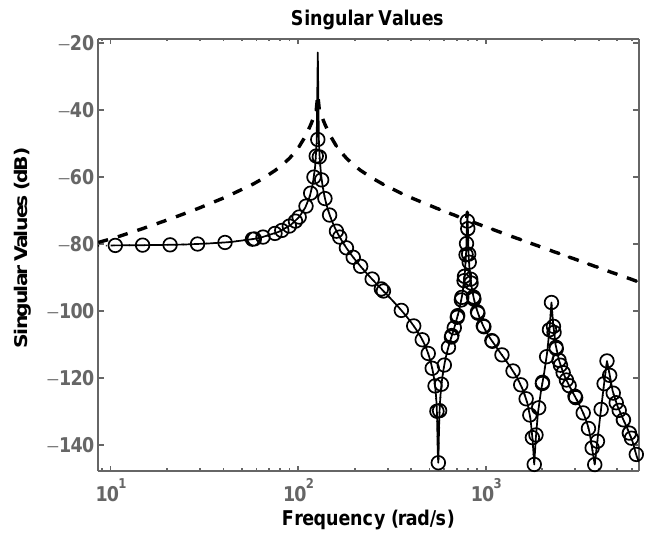
Fig. 6. Singular value diagrams. Continuous line – system without control. Dotted line – closed loop disturbance to control signal. Circles – closed loop disturbance to displacement. Reduced order controller. · · · − 0 . 0163 − 1 . 9707 0 − 0 . 0182 − 3 . 3384 0 1 . 9484 49 .